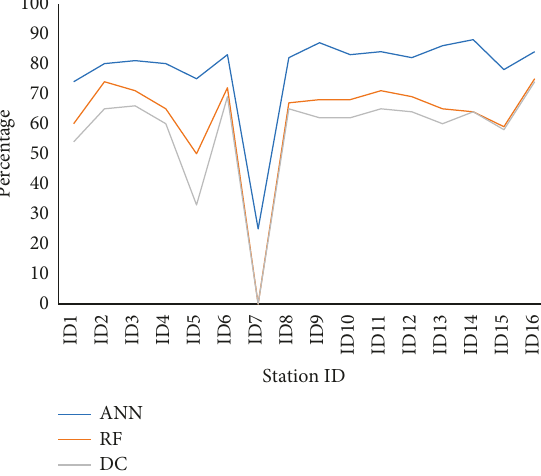
Figure 11: Precision of model for high passenger in each